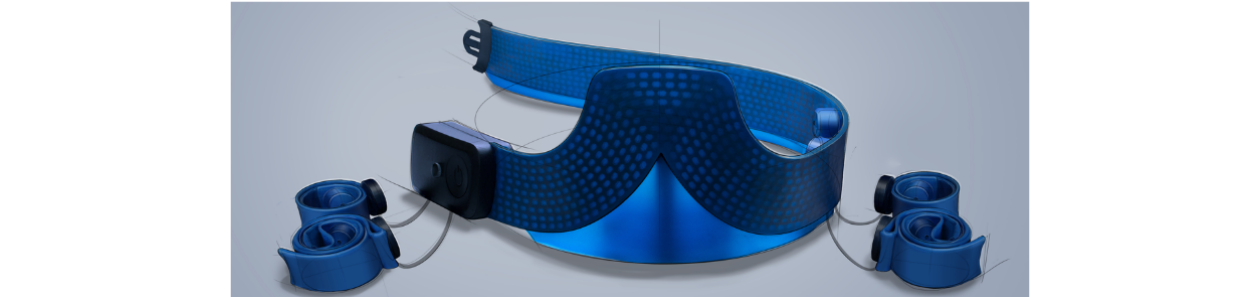
Figure 6. Final design: main belt connected with the limb straps through rolling